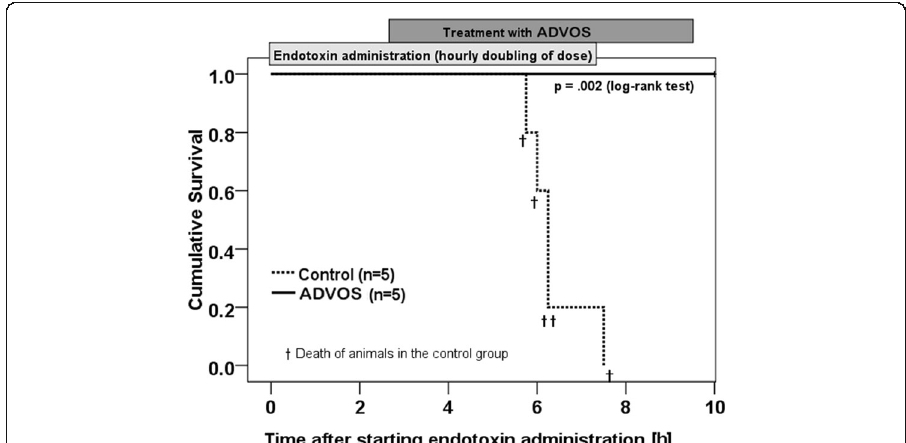
Fig. 3 Log-rank comparison of survival rates between control and ADVOS group systems from T0 to T10 after endotoxin administration. Labels for ADVOS and endotoxin administration are placed in a way that shows the duration of each procedure. All animals in the control group died, while animals treated with ADVOS survived the whole observation period